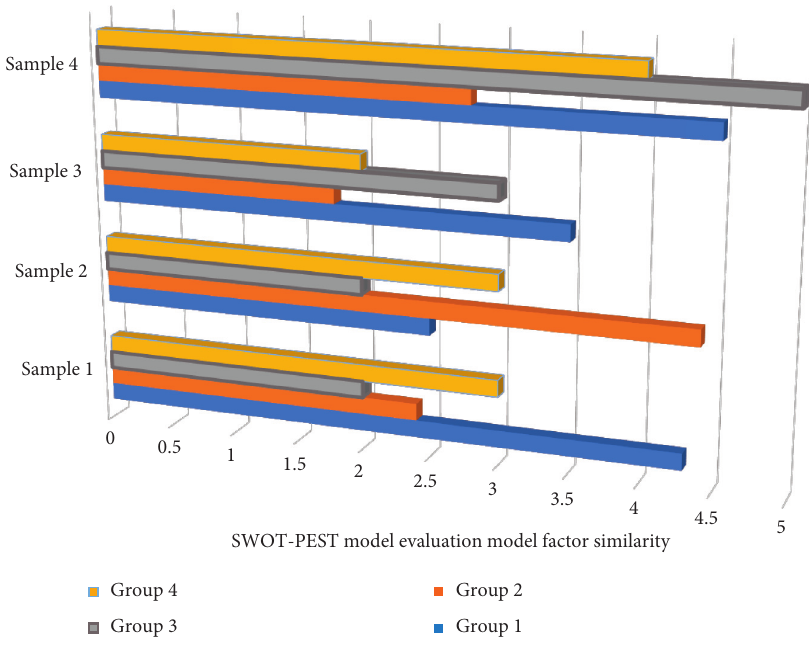
Figure 4: SWOT-PEST model evaluation model factor similarity